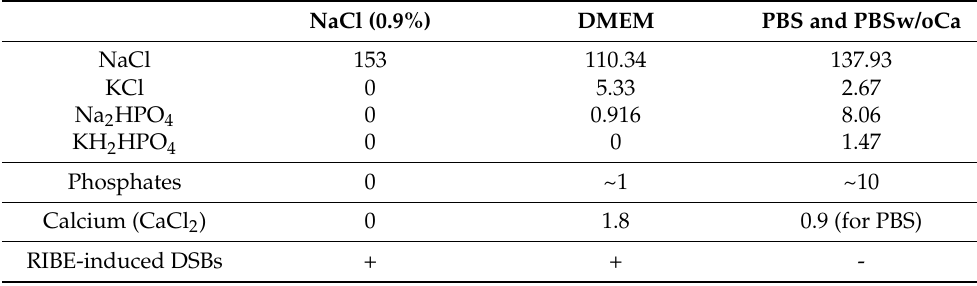
Figure 5. Tiny γH2AX foci as a specific feature of RIBE cells. ( A ) Different patterns of γH2AX foci observed in the radioresistant 1BR3 fibroblasts exposed to 10 mM H 2 O 2 + 1 h, 1 Gy X-rays + 1 h, and 15 J.m −2 UVC + 1 h (left panel). Representative examples of RIBE nuclei after medium transfer (2 Gy; t1 = 10 min; t2 = 4 h) and micro-irradiation (10 Gy; 1 h) (right panel). White arrows indicate tiny foci. Nuclei were counterstained by DAPI. White bars represent 5 µm. ( B ) Average number of MRE11 foci per cell as a function of t2 (for the medium transfer approach after 2 Gy) or as a function of post-irradiation time (for the micro-irradiation approach after 2 Gy). Inserts are representative MRE11 immunofluorescence images assessed 1 h post-irradiation with DAPI counterstaining. White bars represent 5 µm. Table 1. Concentration (mM) of phosphates and calcium in the culture media used